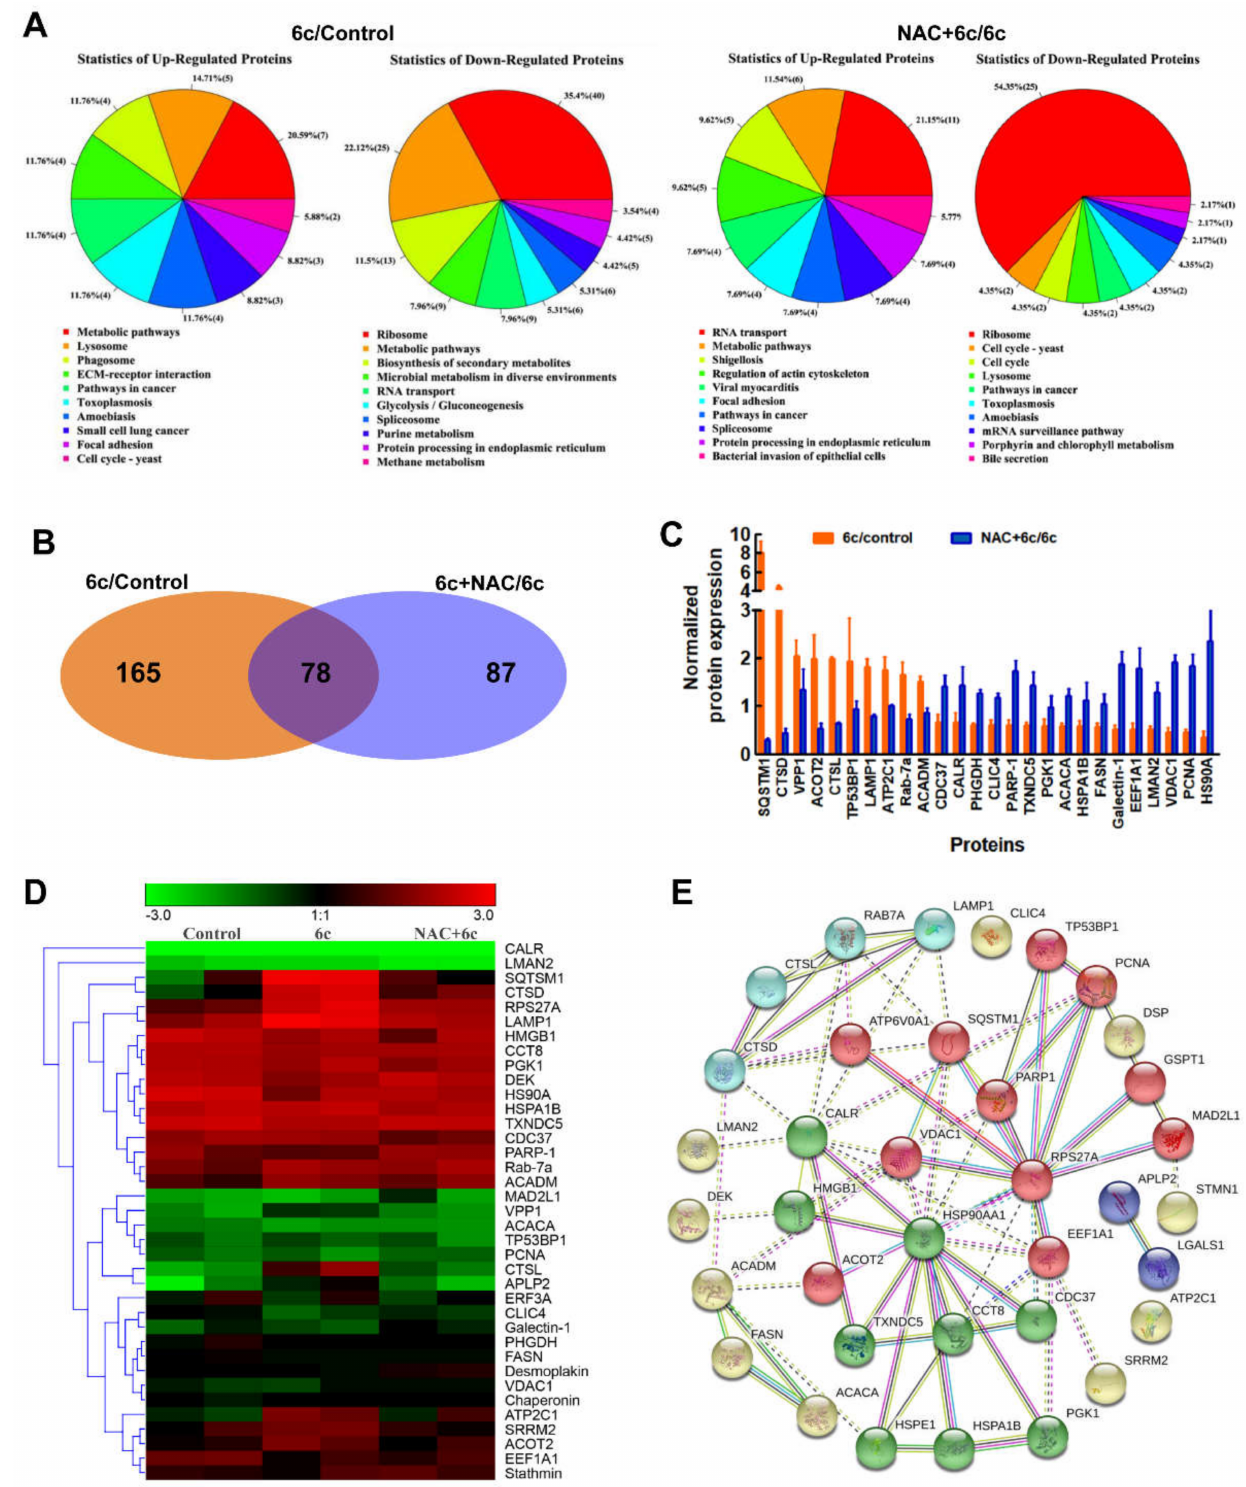
Figure 5. ROS mediated the expression of proteins in HepG2 cells treated with 6c (20 µ M) for 24 h. In order to explore the role of ROS in 6c-treated HepG2 cells, cells were pretreated with NAC (10 mM) for 1 h before 6c addition. ( A ) Statistics of KEGG pathways of up-regulated and down-regulated differential expressed proteins in 6c/control group and NAC+6c/6c groups, respectively. ( B ) Number of differentially expressed proteins and the set relation. ( C ) The relative expression of selective proteins in 6c/control group and NAC+6c/6c group. ( D ) Hierarchical clustering analysis of selective protein changes in observations. ( E ) Protein–protein interaction networks were analyzed from the STRING